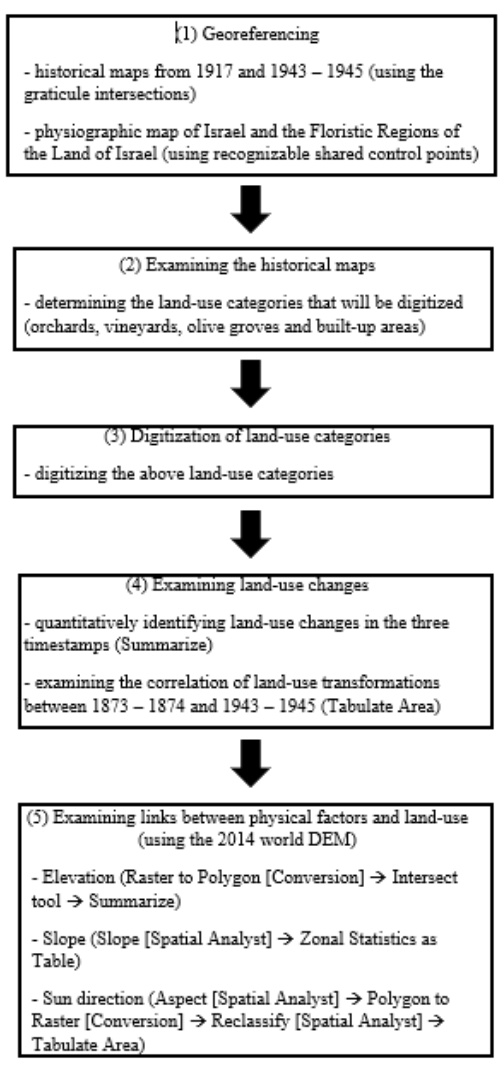
Figure 2. Scheme showing the steps conducted in this